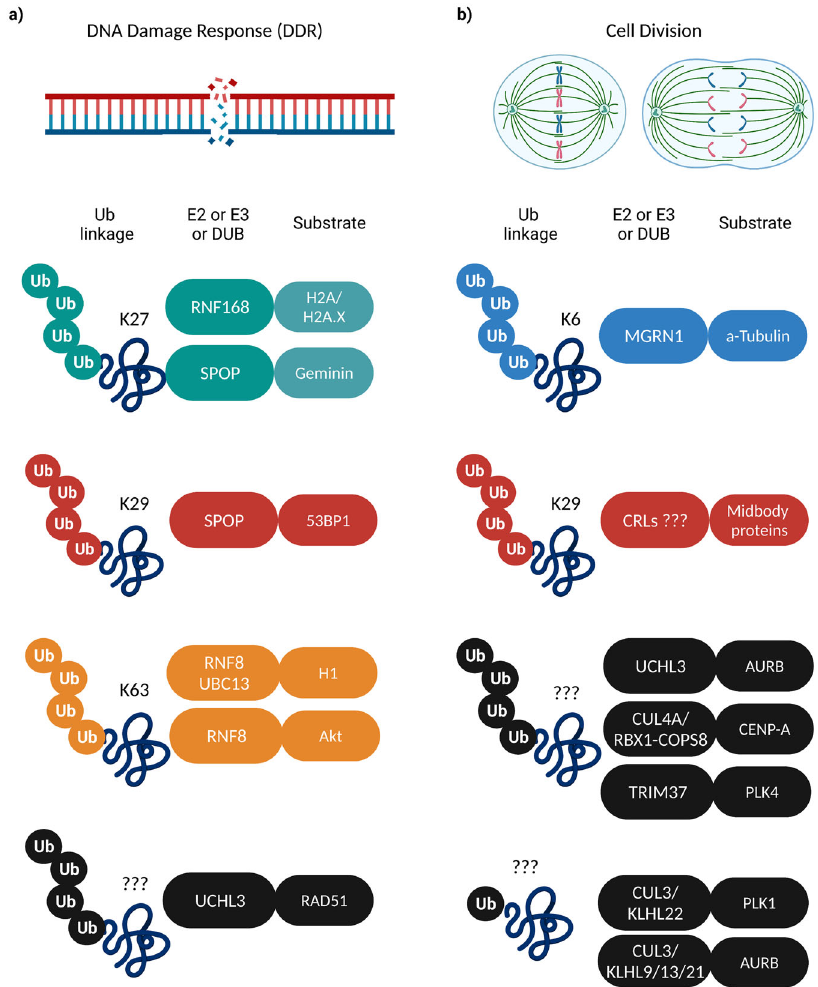
Fig. 2 Non-proteolytic ubiquitylation in DDR and cell division signaling. Examples of reported E2/E3/DUB enzymes (left boxes) and different non- proteolytic Ub signals on the substrate proteins (right boxes) regulating a DDR and b cell division signaling